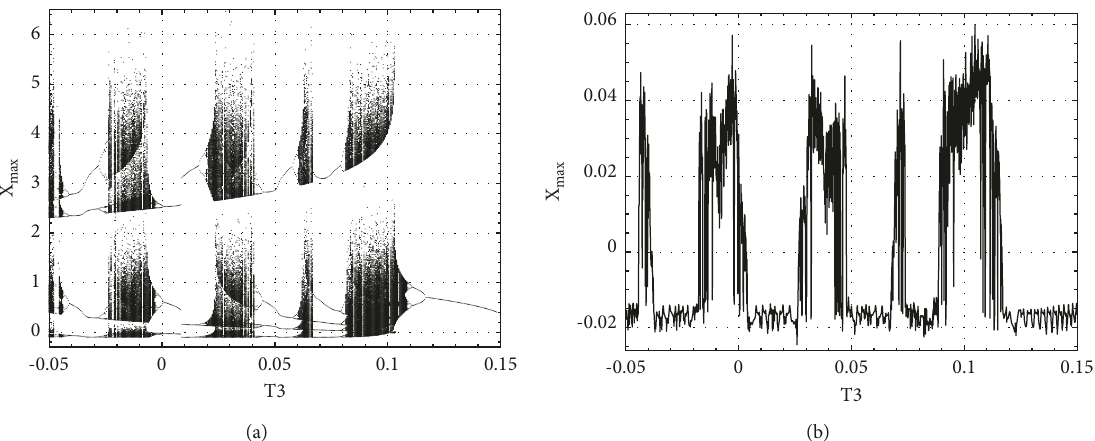
Figure 5: Bifurcation diagram (a) and its corresponding graph of MLE (b) of the motor by variation of the constant load torque. C �